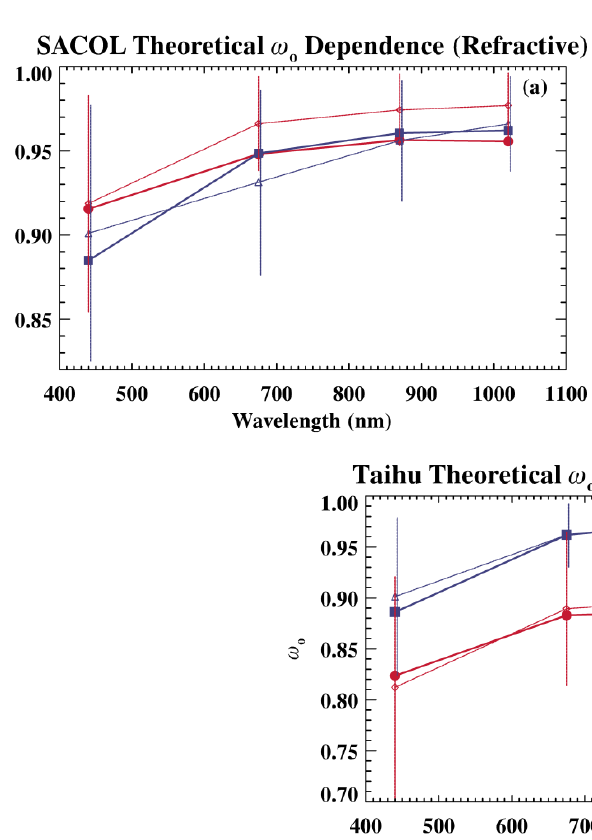
Figure 7. ( a ) Comparison between the observed (solid) and theoretically calculated (dashed) ω for the winter (red circle) and spring (blue box) cases at SACOL, ( b ) Xianghe, o and ( c ) Taihu. The measured complex index of refraction and the effective radii were used as inputs of the model calculation where the effective radius is held constant while the index of refraction